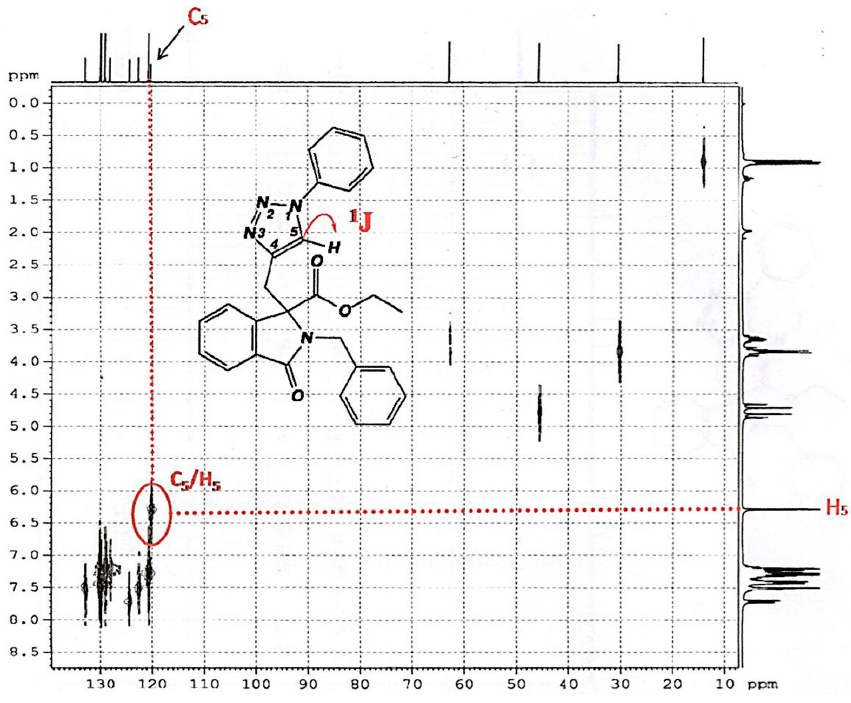
Figure 6. XH correlation spectrum of 6a .